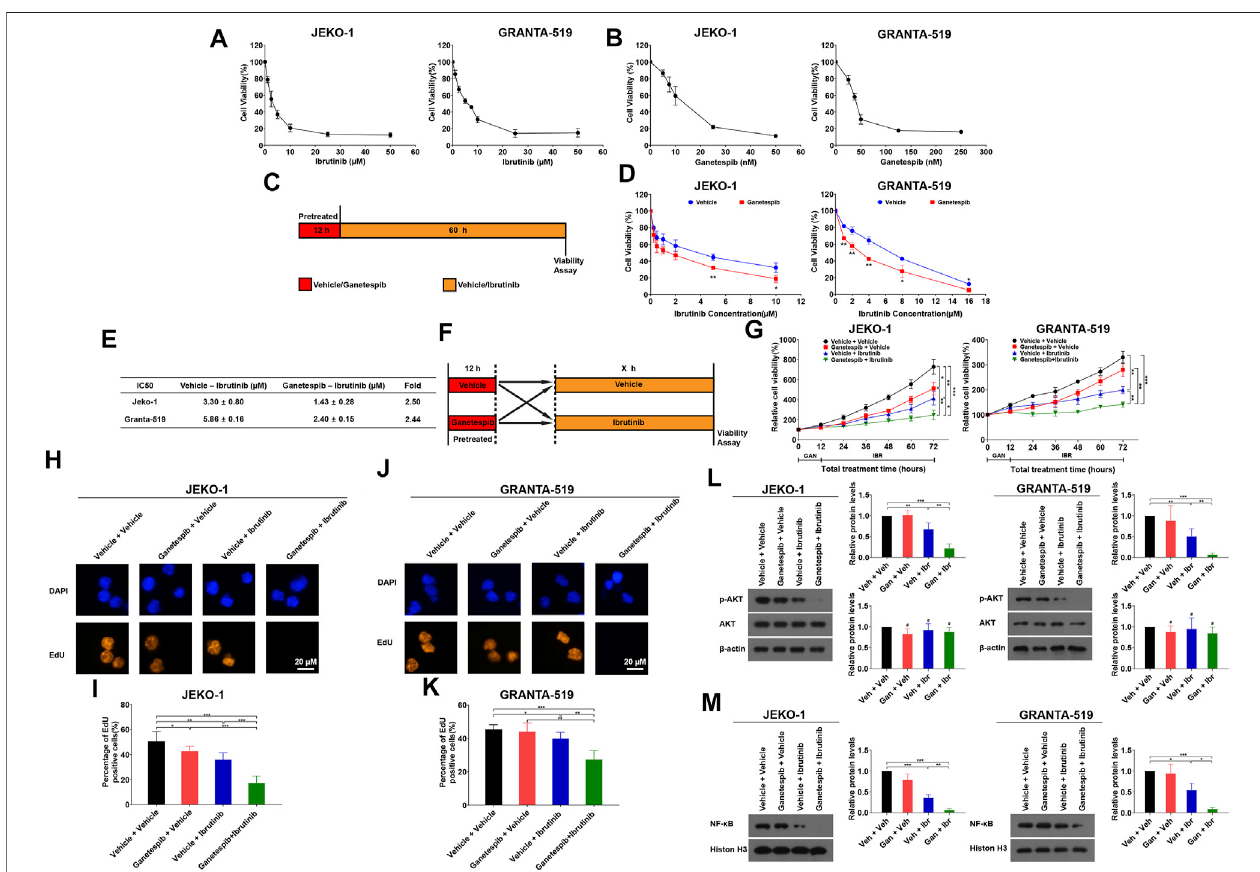
FIGURE 1 | HSP90 inhibitor ganetespib enhanced inhibition of BTK inhibitor ibrutinib on proliferation of MCL cells. (A) Jeko-1 and Granta-519 cells were treated with ibrutinib at the indicated concentration in 0.5% DMSO for 72 h and the cell viability was assessed by MTT assays, respectively. (B) Jeko-1 and Granta-519 cells were treated with ganetespib at the indicated concentration in 0.5% DMSO for 72 h and the cell viability was assessed by MTT assays, respectively. (C) The scheme of experimental settings. Cells were pretreated with either ganetespib at the indicated concentrations or vehicle for 12 h and ganetespib was then washed out. Then thecellsweretreatedwitheitherdifferentconcentrationsofibrutiniborvehiclefor60 hbeforecellviabilitywasassessedbyMTTassays. (D) Jeko-1andGranta-519cells were treated with ganetespib (15 nM for Jeko-1 and 45 nM for Granta-519 cells, respectively) in 0.5% DMSO for 12 h, and then treated with different concentrations of ibrutinibasindicatedin0.5%DMSOfor60 hbeforecellviabilitywasdetectedbyMTT. (E) IC 50 valuescalculatedbyusingdatafrom (D) . (F) Theschemeofexperimental settings. Cells were pretreated with either ganetespib (15 nM for Jeko-1 and 45 nM for Granta-519 cells, respectively) or vehicle for 12 h and then treated with either ibrutinib at 6 μ M or vehicle for various periods of time as indicated before cell viability was assessed by MTT assays. (G) . Jeko-1 and Granta-519 cells were treated with either ibrutinib at 6 μ M or vehicle for various periods of time as indicated before cell viability was assessed by MTT assays. (H – M) Jeko-1 and Granta-519 cells were pretreated with either ganetespib (15 nM for Jeko-1 and 45 nM for Granta-519 cells, respectively) or vehicle and then treated with either ibrutinib at 6 μ M or vehicle for 24 h. (H – K) Representative pictures and the statistics ofEdU staining of JEKO-1 (H,I) and Granta-519 cells (J,K) . (L) The protein levels and statistical analysis ofp-AKT and AKT in Jeko-1 and Granta-519 cells treated as mentioned. (M) The protein levels and statistical analysis of NF- κ B from nuclear extracts in Jeko-1 and Granta-519 cells treated as mentioned. Mean ± SD, n = 3.